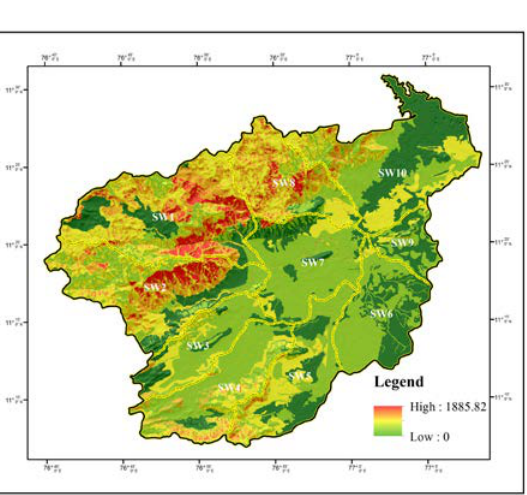
Figure 11. Soil Erosion Hazard (A=RKLSCP)